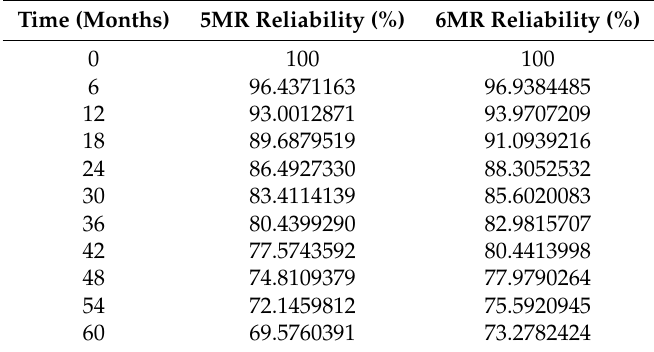
Table 2. 5MR and 6MR reliability ( λ s = 5 λ d ).